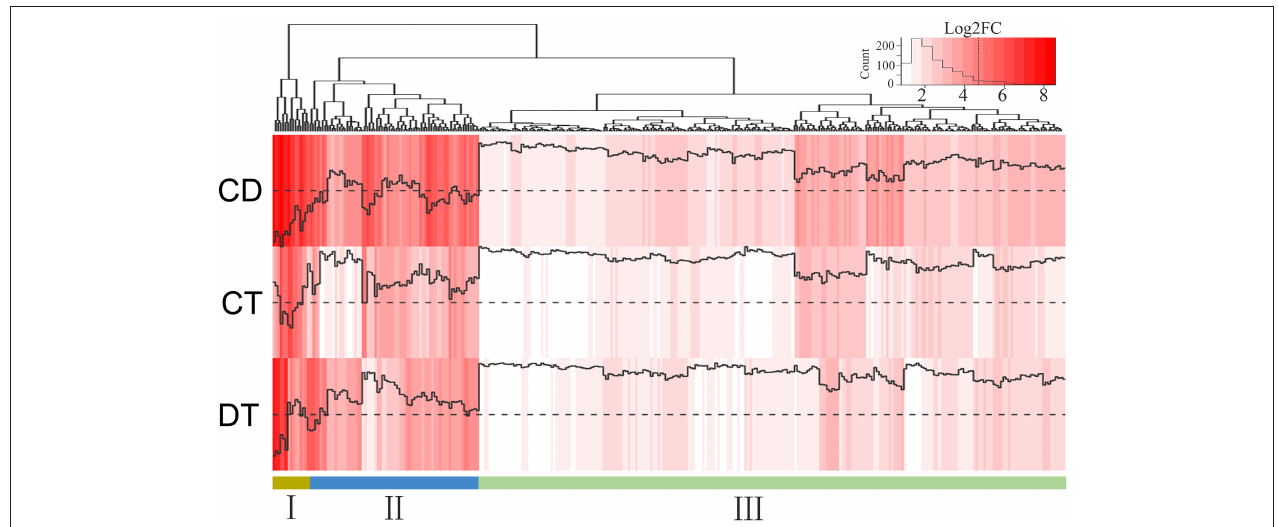
FIGURE 6 | Heat map of 319 co-up-regulated DEGs that showed enhanced expression under CD compared with CT and DT. Color indicates fold change of DEGs under CT, DT and CD, as shown in the